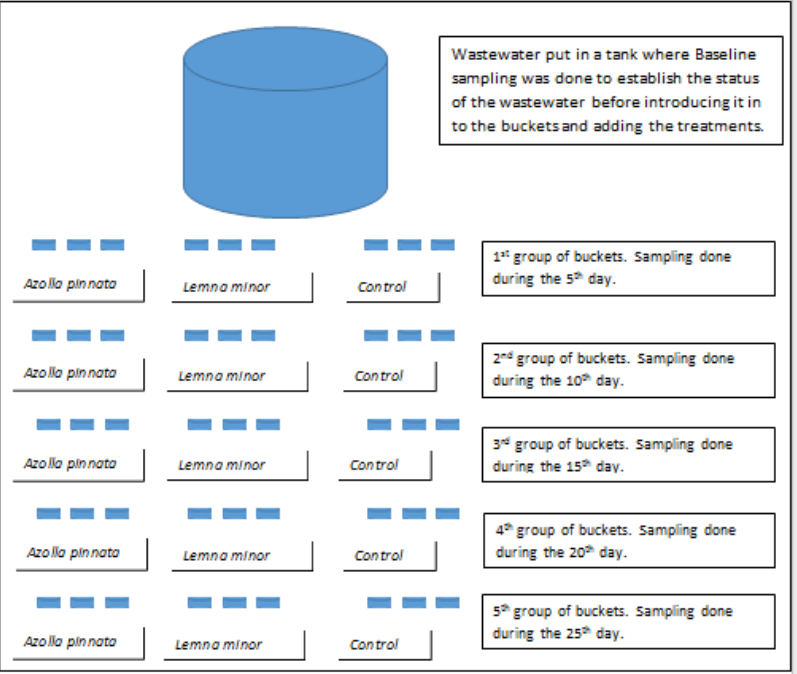
Fig 2: A diagram representing the experimental set up and the sampling sessions